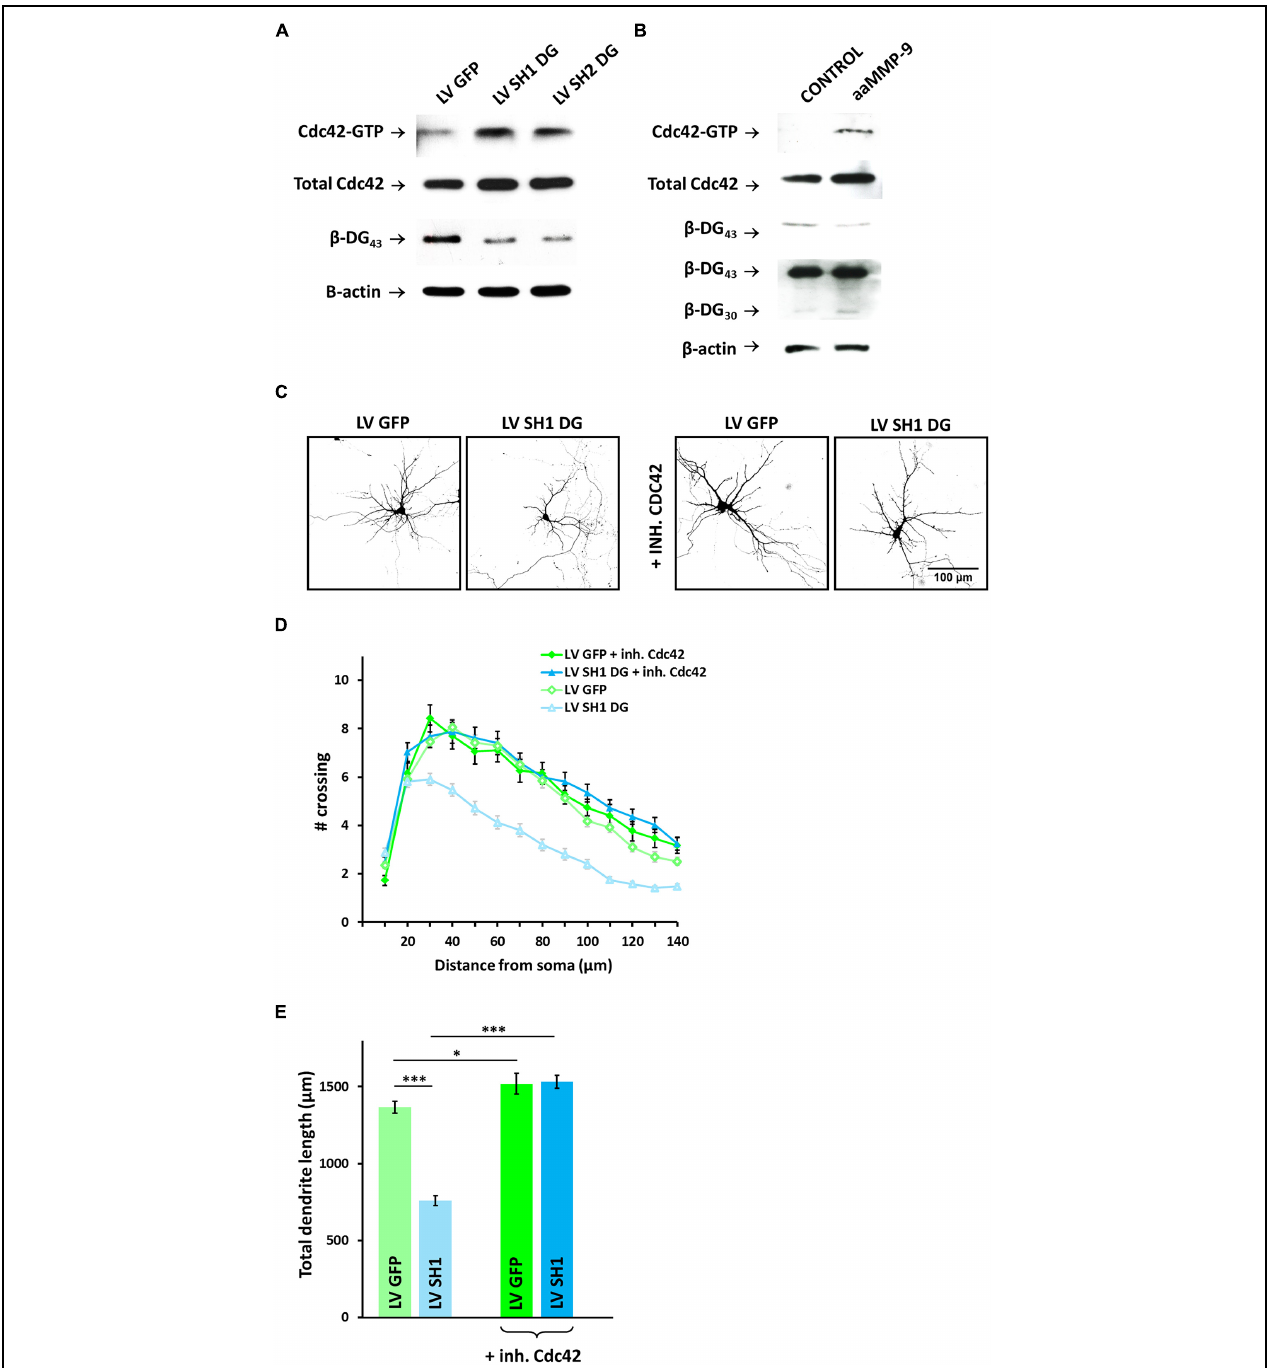
FIGURE 5 | Cdc42 activity contributes to dendritic atrophy caused by DG knockdown or MMP-9 treatment. (A) Western blot analysis of active Cdc42 (Cdc42-GTP) and total Cdc42 in cortical neurons infected with LV GFP, LV SH1 DG, or LV SH2 DG. Silencing efficiency was checked by immunoblotting with anti- β -DG antibody. β -actin was used as a loading control. (B) Western blot analysis of active Cdc42 (Cdc42-GTP) and total Cdc42 in control and aaMMP-9-treated cortical neurons. Immunoblotting with anti- β -DG served as a control for the proteolytic activity of MMP-9. β -actin was used as the loading control. (C) Representative images of neurons used for the morphometric analysis. The cells were transfected with an